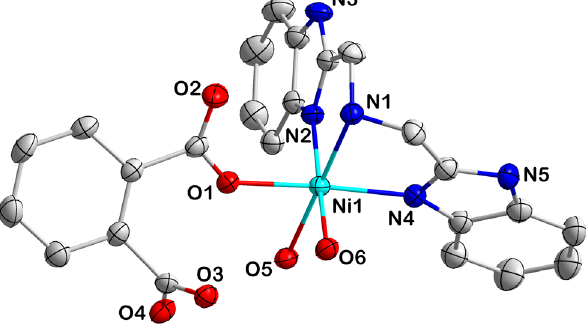
Table  : Fractional atomic coordinates and isotropic or